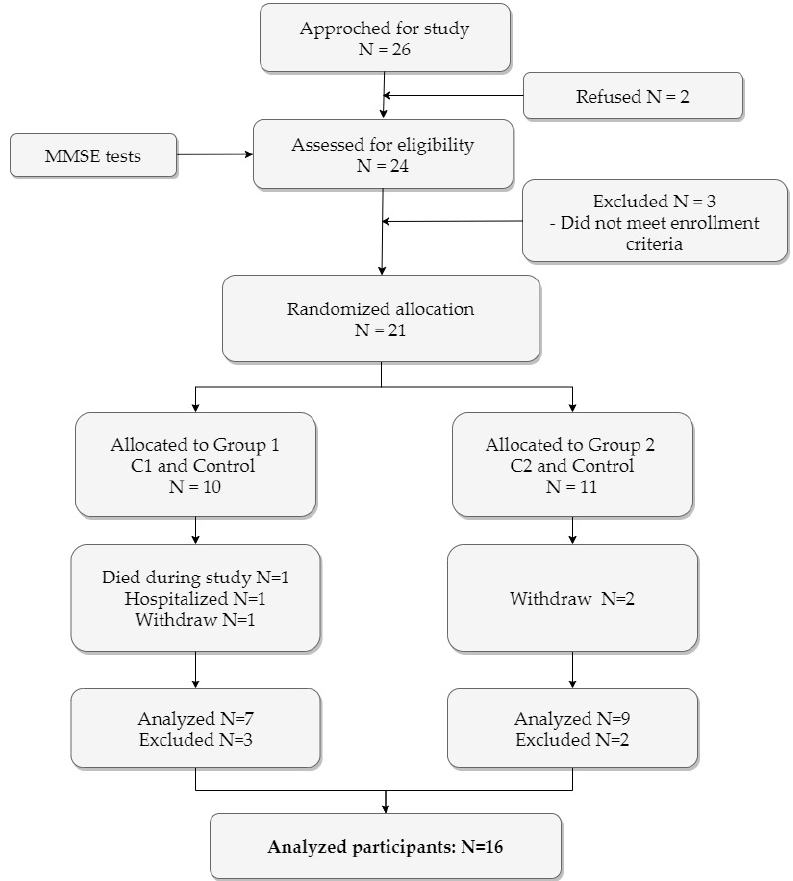
Figure 2. Flow diagram of recruitment, enrollment, allocation, and the number of participants.